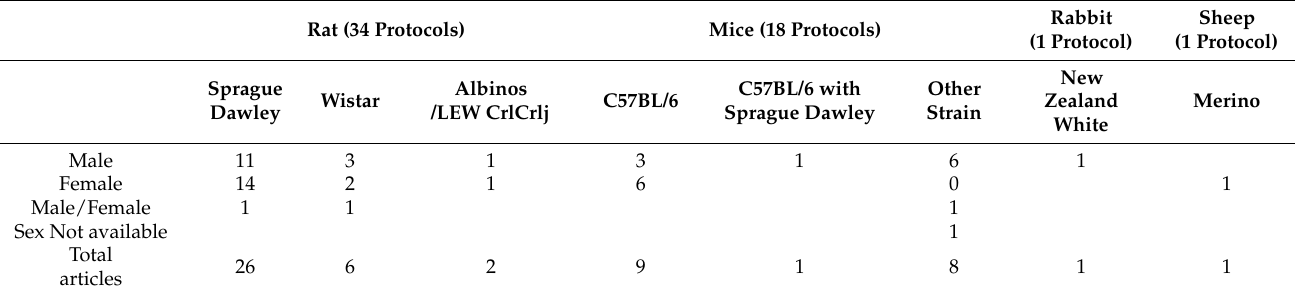
Table 1. Number of articles by species, strain, and sex in the GIOP model. One paper [28] included both mice and rats with different protocols.